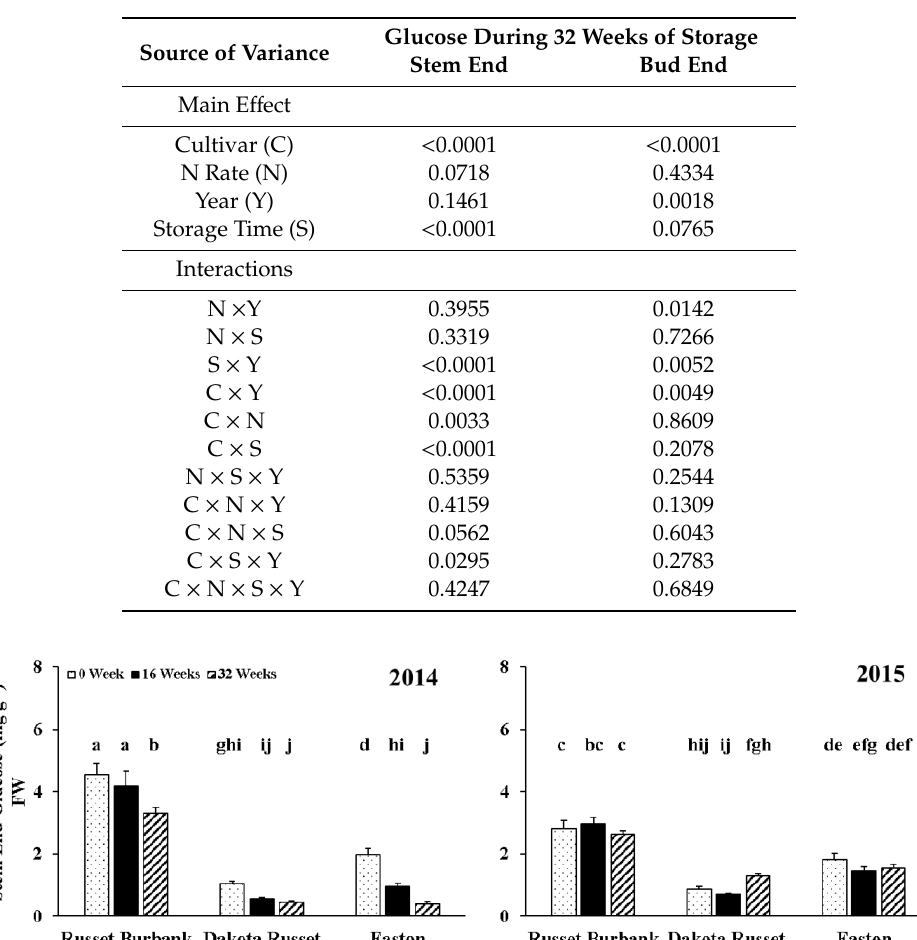
Figure 1. Three-way interaction of cultivar by storage time by year effect on stem-end glucose concentrations in 2014 and 2015 (Means were separated at the 5% level, with the same letter above the bar indicating no significant difference.). FW: Fresh weight.